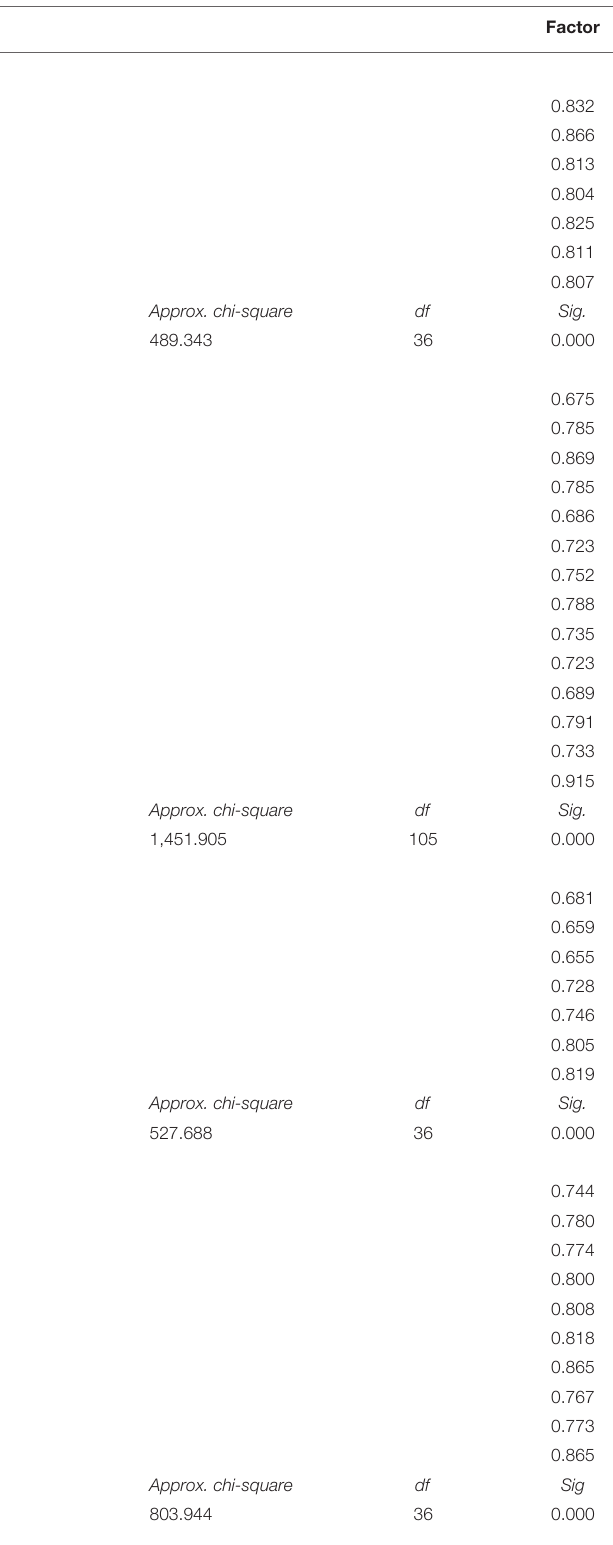
TABLE A1 | Factor loadings of the